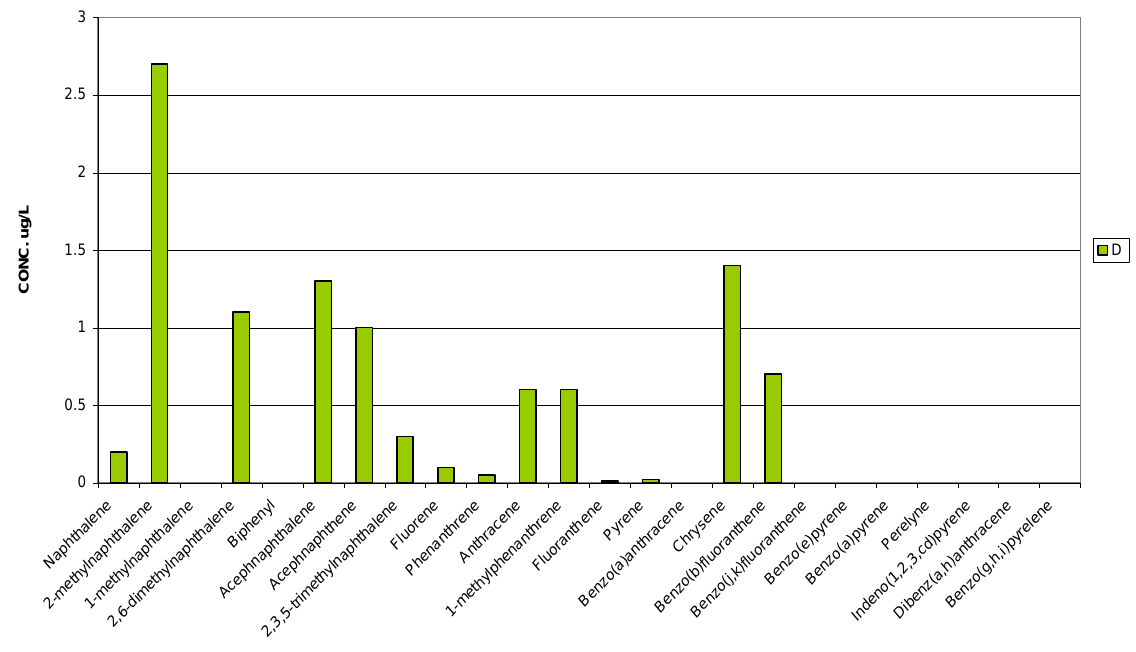
FIGURE 5. The average PAHs found in the Sakumono Lagoon